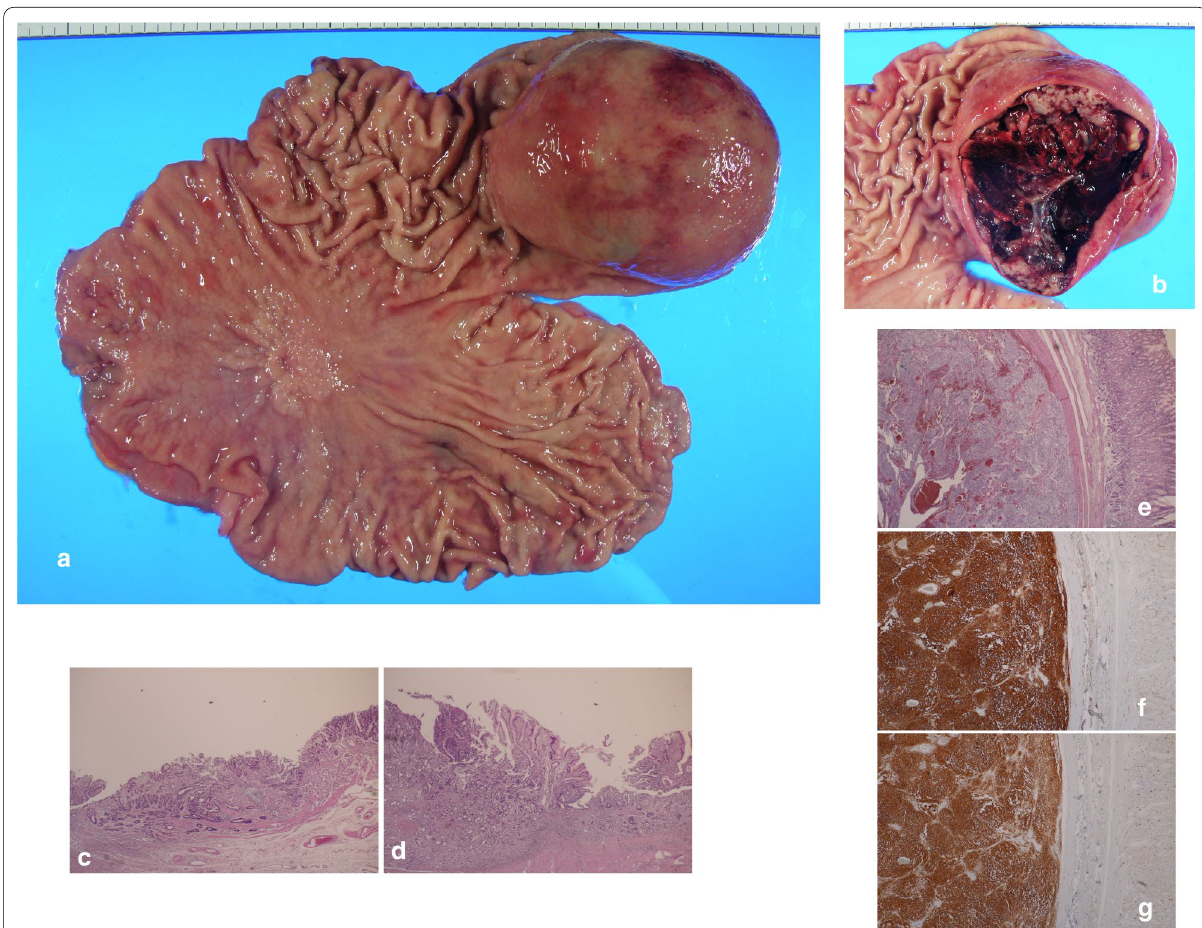
Fig. 4 a Macroscopically total gastrectomy specimen showed a 0–IIc lesion measuring 34 65 92 mm. b Contents of the cystic lesion were a papillary tumor constituting the cyst wall, necrotic tissue, and a large amount of coagula. × c , d Histopathologically a 0–IIc lesion showed shallow infiltration to muscularis propria by well-differentiated adenocarcinoma (hematoxylin and eosin stain, magnification 20). e Papillary tumor was composed of spindle-shaped cells with oval nuclei (hematoxylin and eosin stain, × magnification 20). f , g Immunohistochemical studies indicated strong staining for CD34 ( f ) and CD117(c-KIT) ( g ) (magnification ×